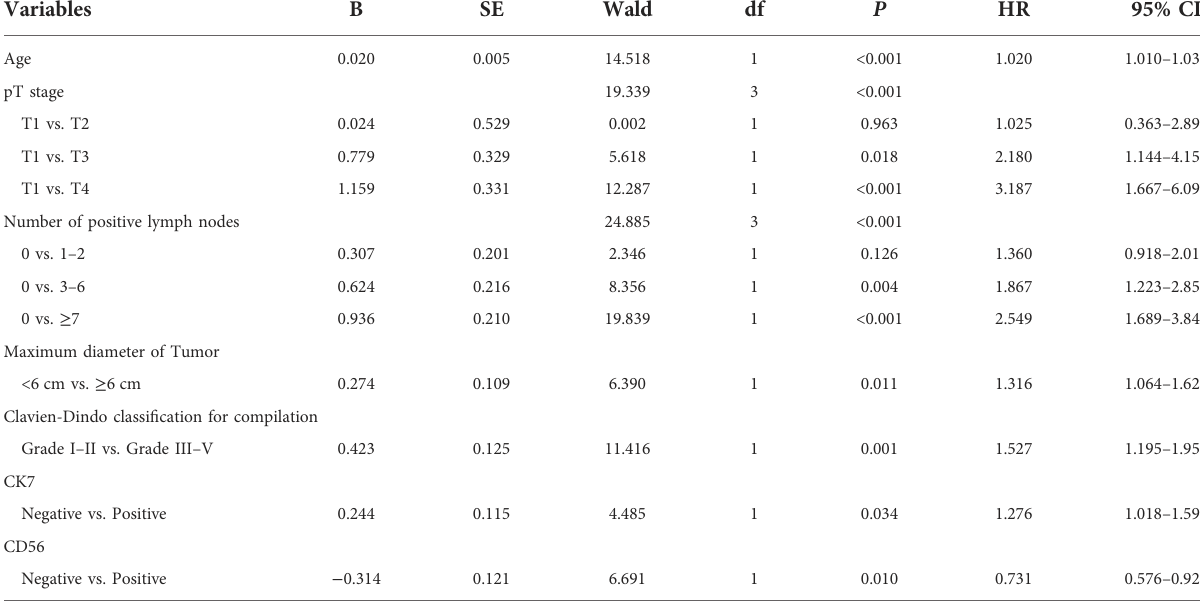
TABLE 3 Multivariate analysis of OS of training cohort of chemotherapy cycle ≥ 9 and analyzed by Cox regression.